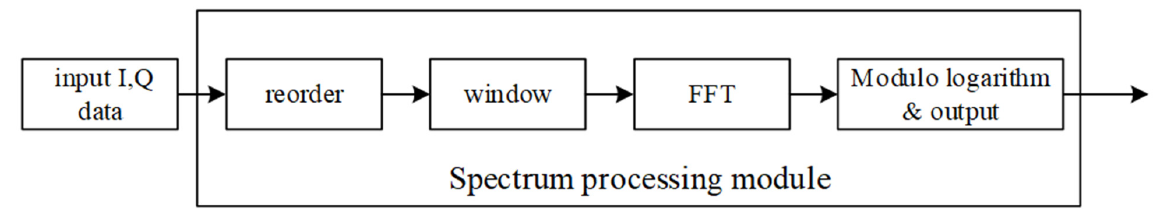
Figure 6. Algorithm implementation of the spectrum processing module.